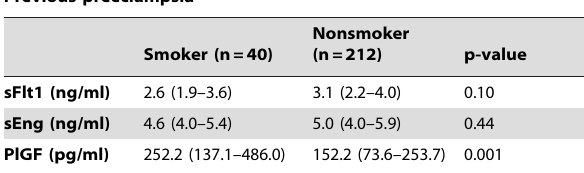
Table 4. Comparison of angiogenic factors in pregnant women with preeclampsia in a previous pregnancy: smokers versus nonsmokers.*